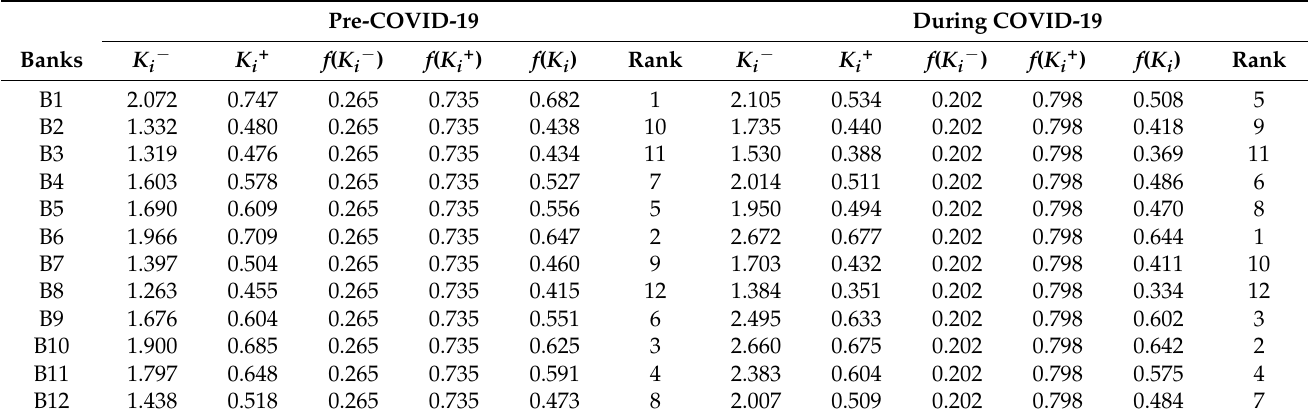
Table 15. The bank efficiency ranking pre- and during COVID-19.